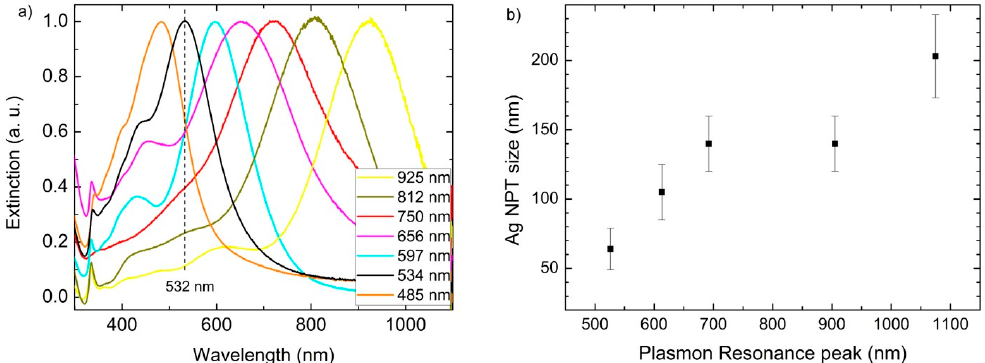
Figure 2. Optical absorption spectra from Ag NPT solutions prepared by seed-mediated growth and tested for NLO properties (a); SPR vs. NPTs size measured using AFM (b).